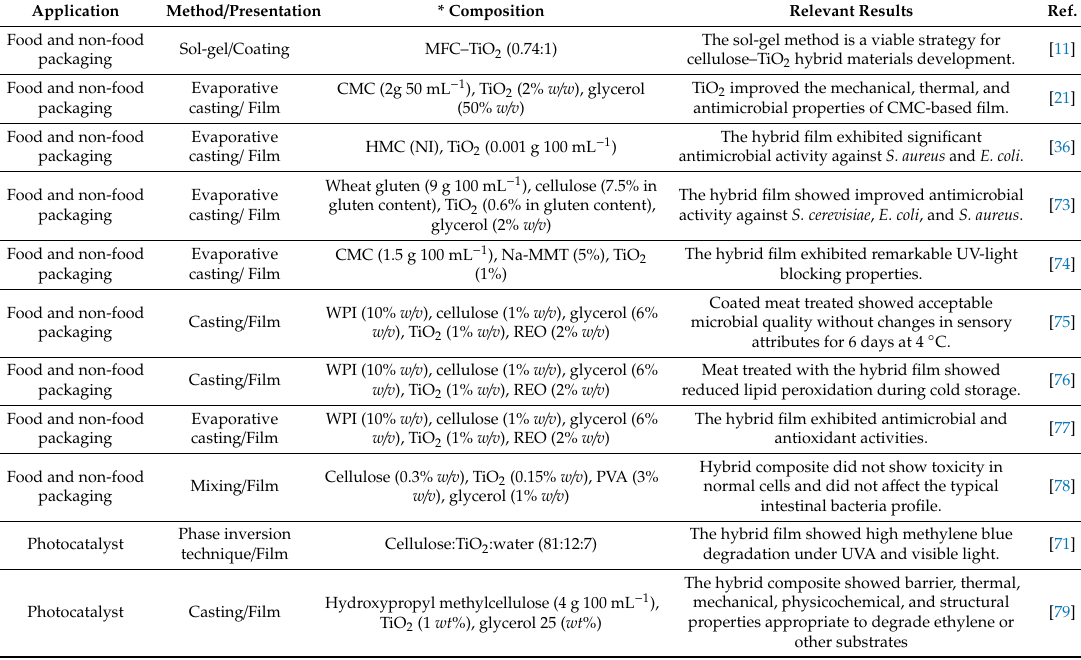
Table 3. E ff ect of TiO 2 incorporation on cellulose-based materials